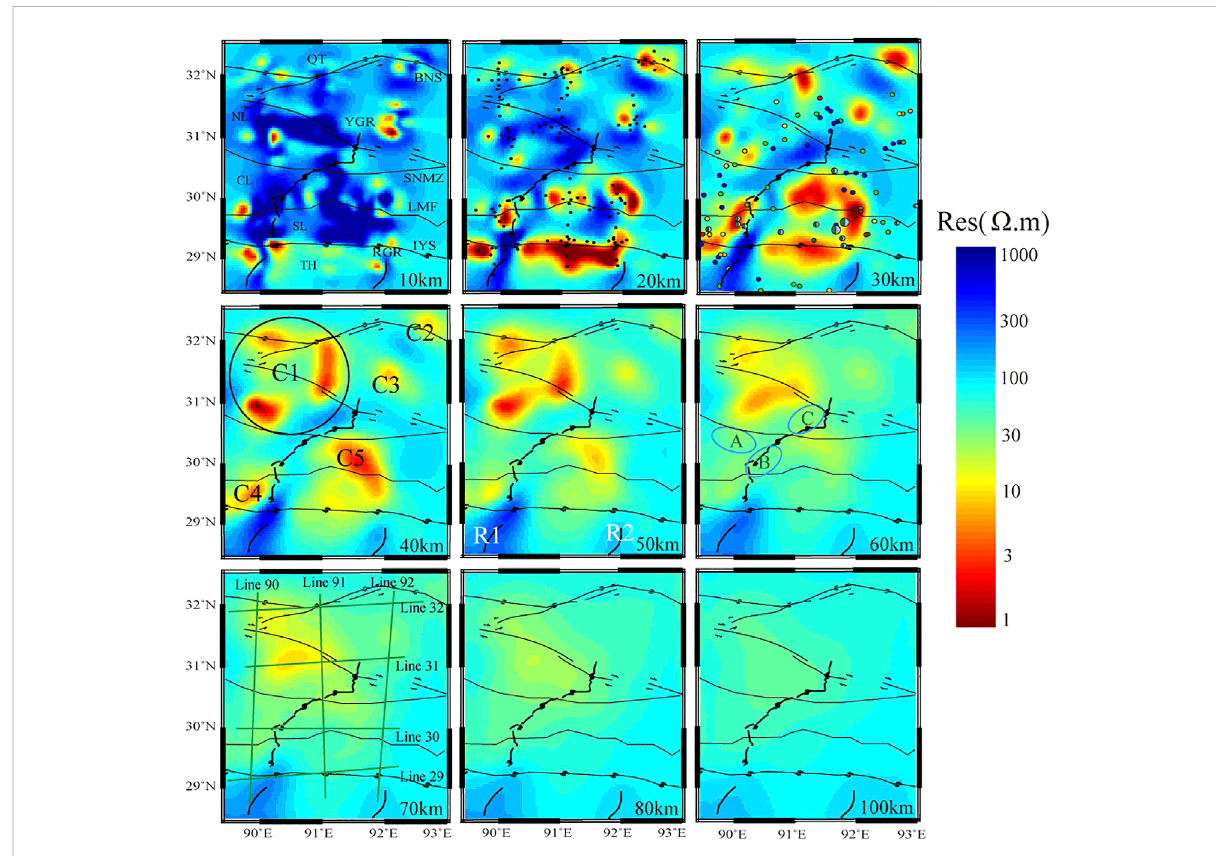
FIGURE 5 Horizontal slices of the 3-D electrical resistivity model for depth of 10, 20, 30, 40, 50, 60,70, 80, and 100 km. See Figure 1 for